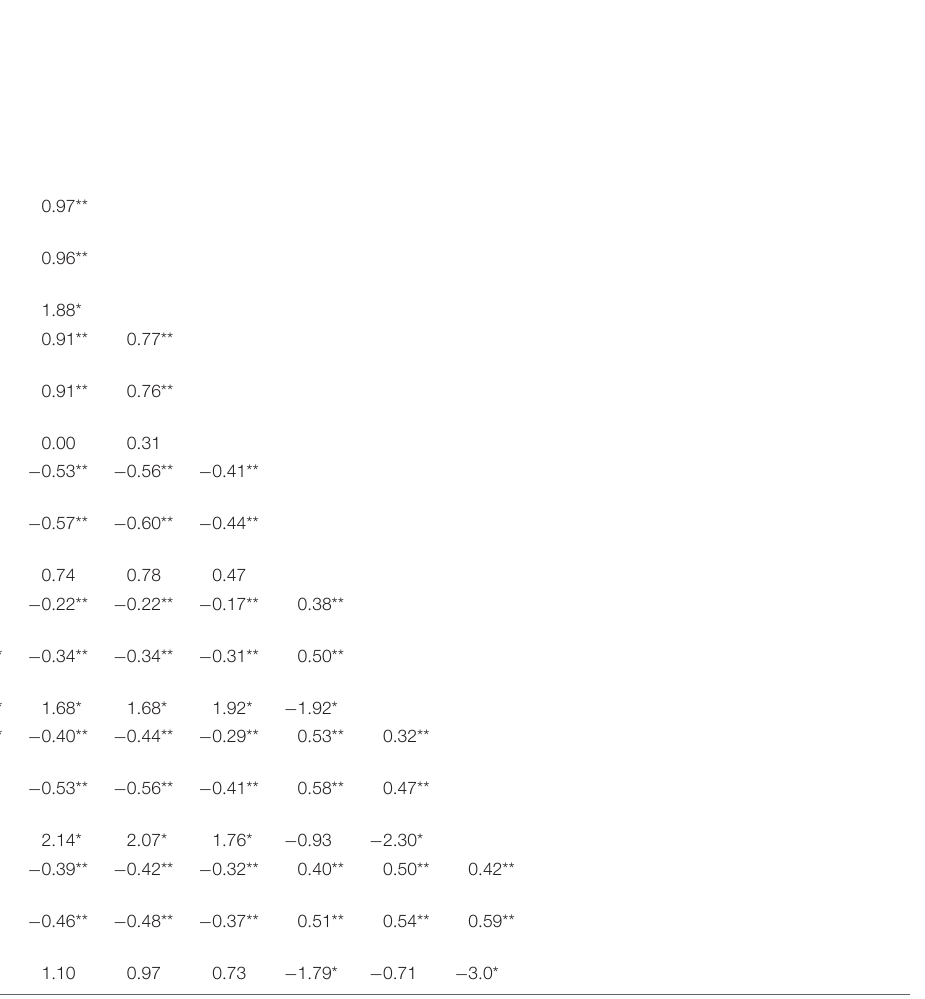
TABLE 1 | Means, standard deviations, reliability, Pearson’s correlations between HSCL-25, RSE, self-efficacy, SWL, and READ scores for Germany ( N = 321), and Switzerland ( N = 349). Mean SD α 95% CI [LL,